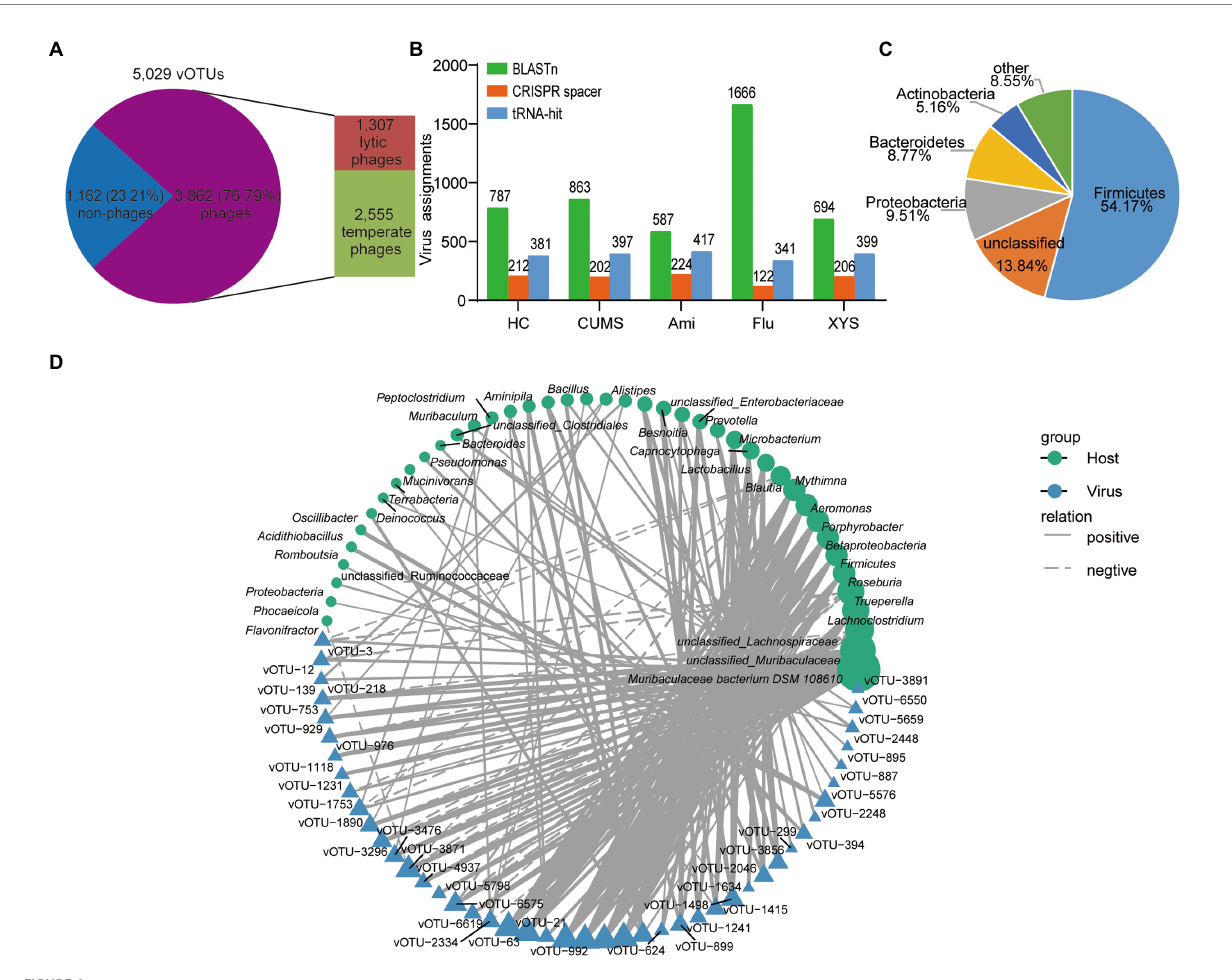
FIGURE 4 Correlations between gut viruses and bacterial hosts. (A) The distribution of the temperate and lytic phages. (B) Total number of host assignments to metagenomic viruses using three methods. Total assignments for BLASTn, CRISPR spacer and tRNA-hit are shown above each bar. (C) The proportion of vOTUs that are predicted to infect microbial hosts at the phylum level. (D) The interaction network of bacterial genera and vOTUs determined by Cytoscape v3.7.1. Only connections with a strong (Pearson’s | ρ | > 0.7) and significant ( p < 0.01) correlation are presented in the network. Circles and triangles represented the different bacteria and viruses, with solid and dashed lines indicating the positive and negative correlations,